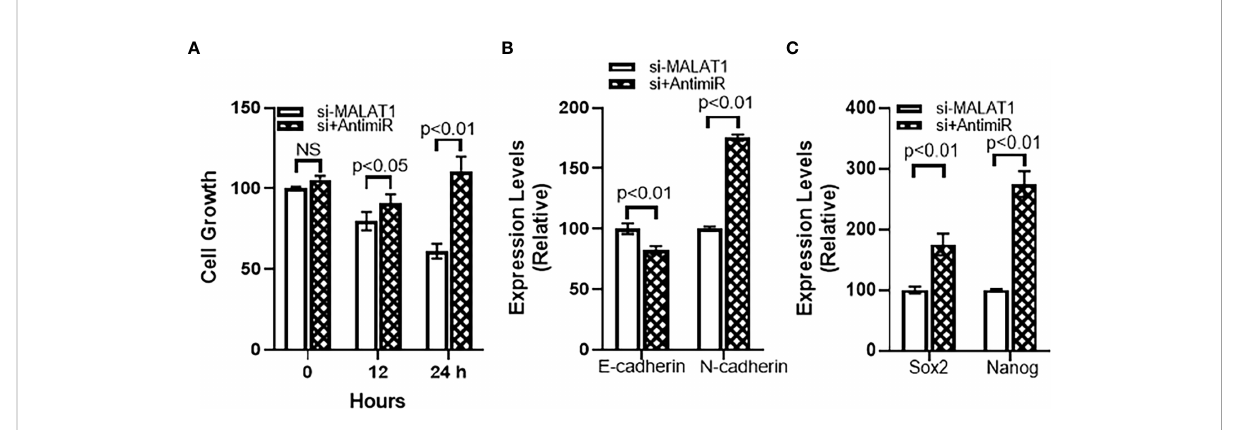
FIGURE 6 miR-124 reverses MALAT1-silencing effects on (A) cell growth, (B) EMT and (C) cancer stem cells characteristics. si+AntimiR: siMALAT1+Anti- miR-124. NS, not signi fi cant.